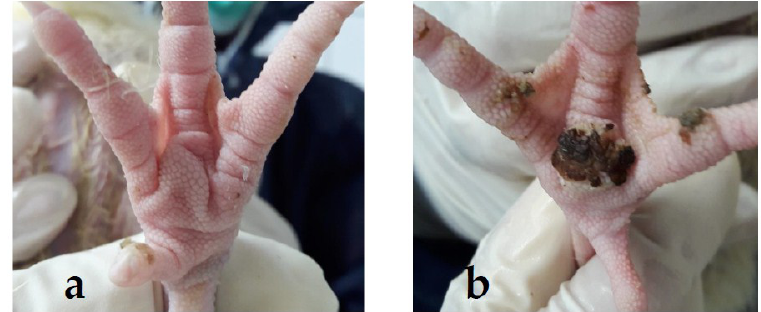
Figure 2. Photograph of foot pad lesions with different scores. ( a ) Category 0: no alterations detected; and ( b ) Category 4: more than half of the foot pad covered with necrotic cells (photo: © Chuppava/TiHo).